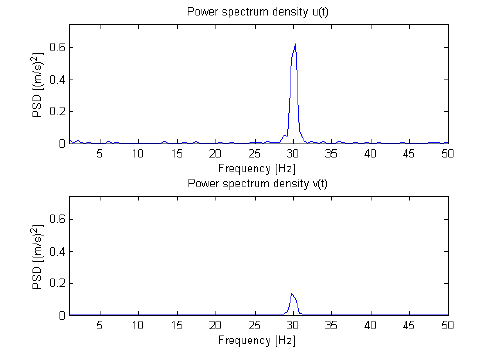
Fig. 11c. ϕ=π . Freq. spectrum at point X for regime III.